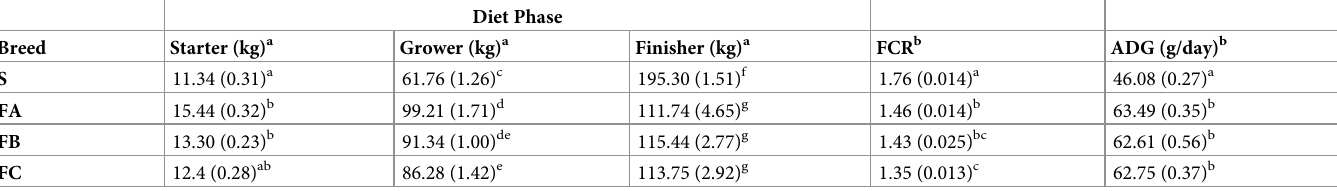
Different letters denote signicant differences (P < 0.05). a